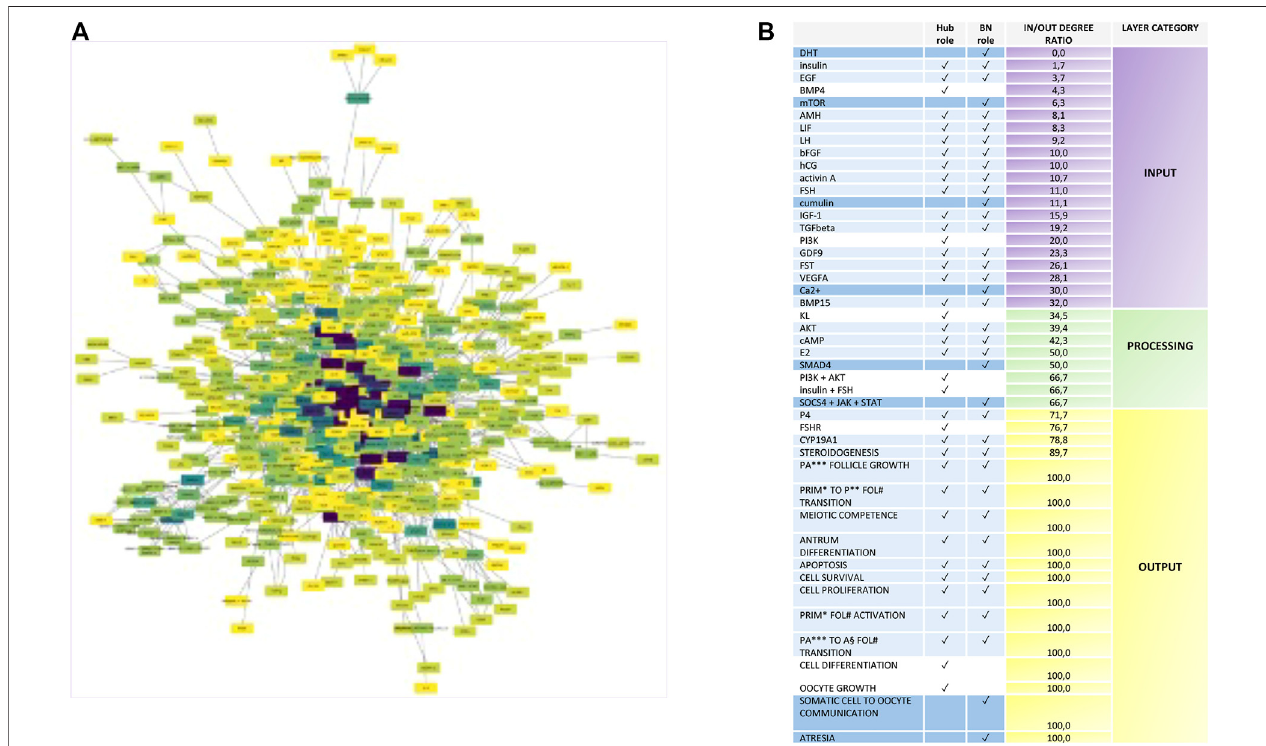
FIGURE 3 | Nodes with Hub, bottleneck, and hub.BN role strati fi cation into the ivF network. (A) Diagram showing the signal strati fi cation of the ivF network. The color gradient varies depending on the direction of links characterizing each node, computed as in/out degree ratio, from purple (higher) to yellow (lower) . The spatial networkarrangementwasobtainedbyusingtheCytoscapeprefuseforce-directed layout. (B) Nodeclassi fi cationdependingontheirroleinthesignalpropagationinthe input layer (green scale color), processing layer (yellow scale color), and output layer (red scale